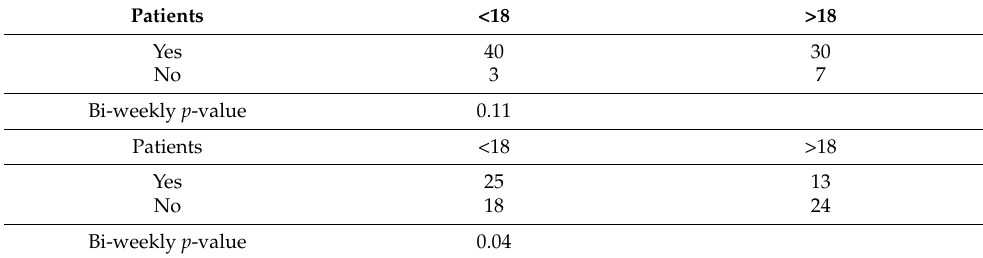
Table 2. Chi-square tests performed among the patients, investigating the correlation between age and availability to take/examine pictures twice-a-week or weekly,